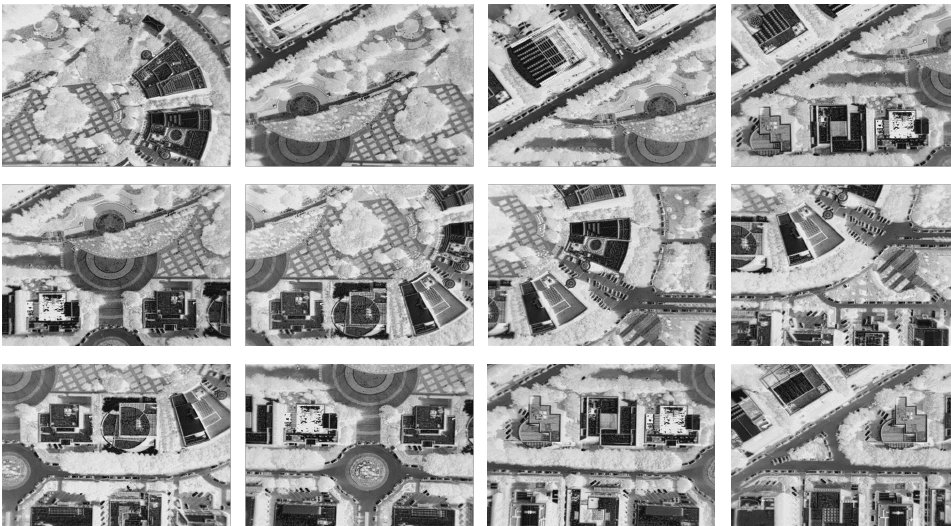
Figure 12. Samples of the real-time infrared